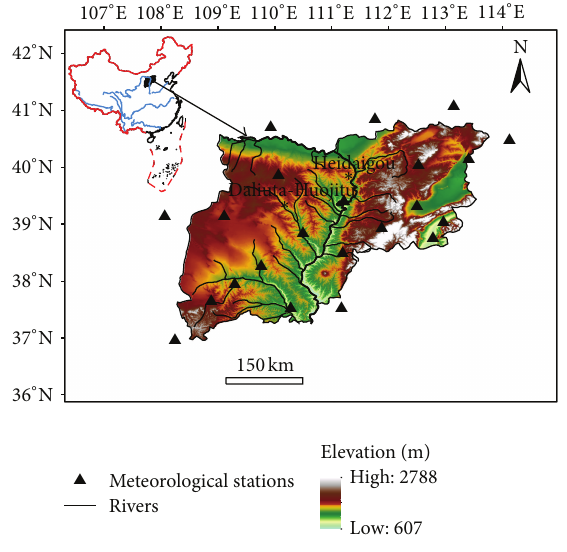
Figure 1: Location of the study